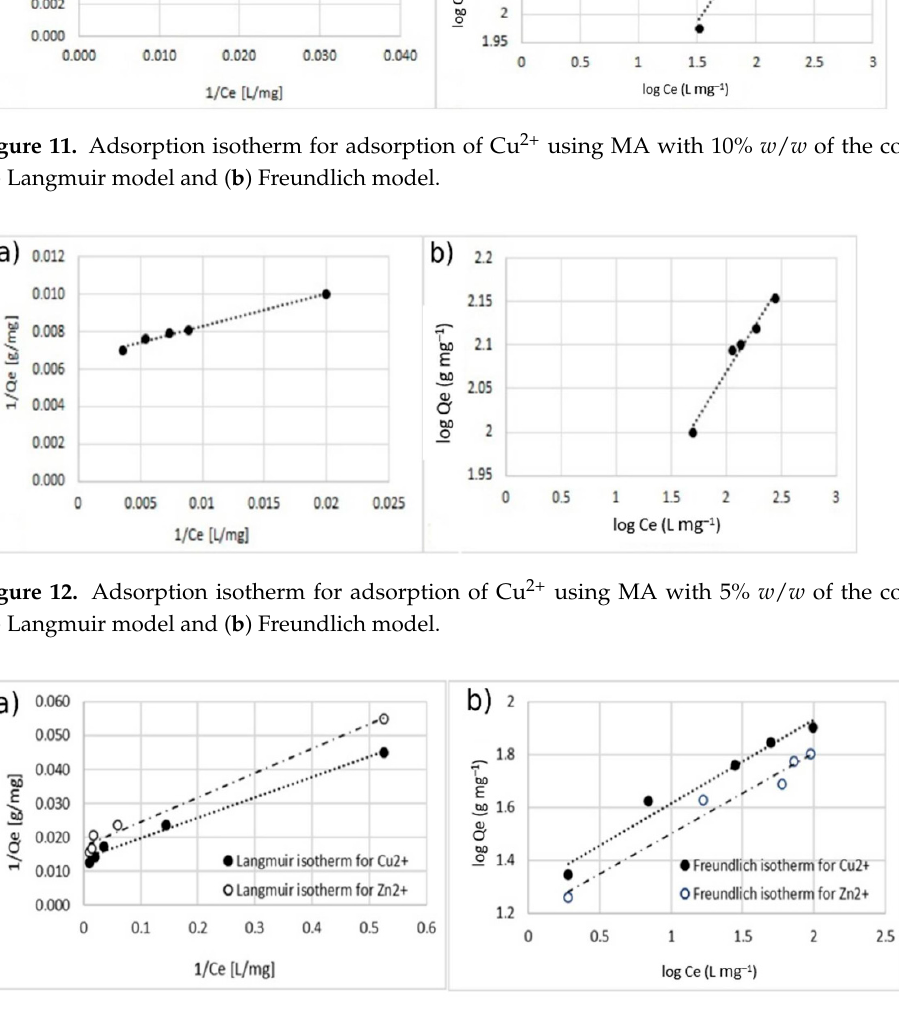
Figure 13. Adsorption isotherm for adsorption of Cu 2+ and Zn 2+ using MA with 10% w / w of coating. ( a ) Langmuir model and ( b ) Freundlich model.